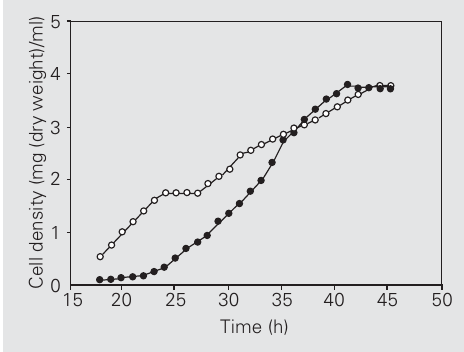
Figure 1. Growth of Candida utilis in trehalose or glucose me- dia. C. utilis cells (800 µg dry weight) from a liquid culture in YNB medium containing 1% tre- halose at 3.8 mg (dry weight)/ml were inoculated into 100 ml of YNB media containing 1% treha- lose (filled circles) or 1% glucose (open circles). The cultures were incubated in an orbital shaker at 28 º C and 160 rpm and growth was monitored by measuring ab- sorbance at 570